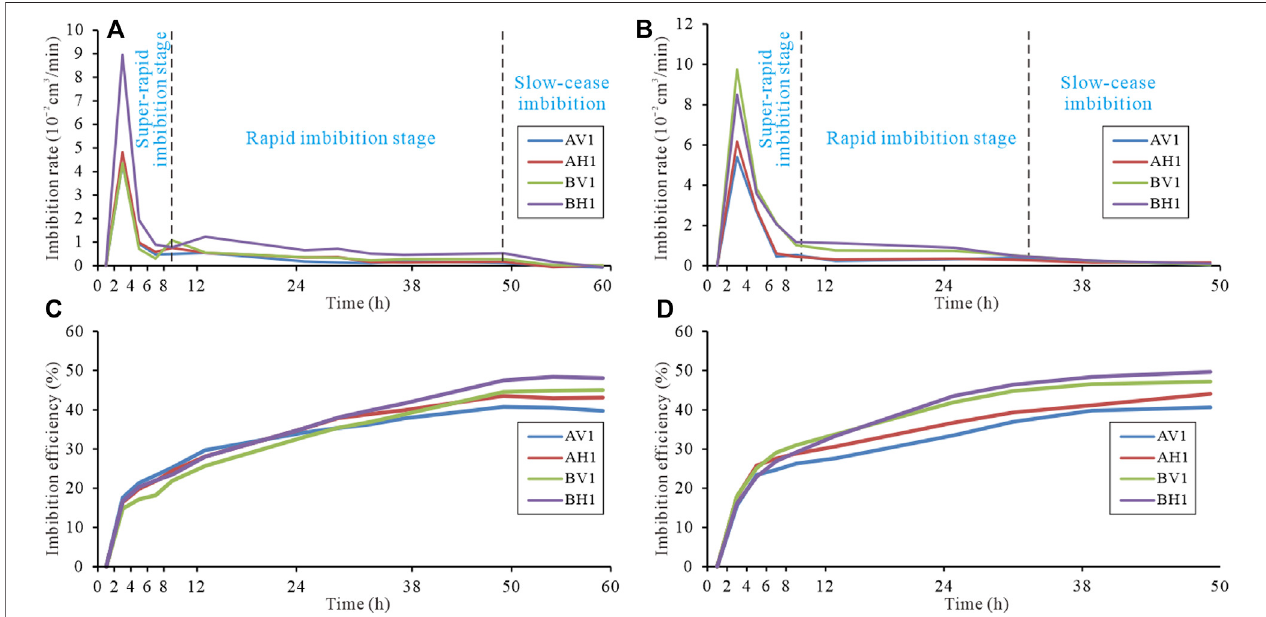
FIGURE 8 | Imbibition ef fi ciency (A,B) and imbibition rates (C,D) at different temperatures.